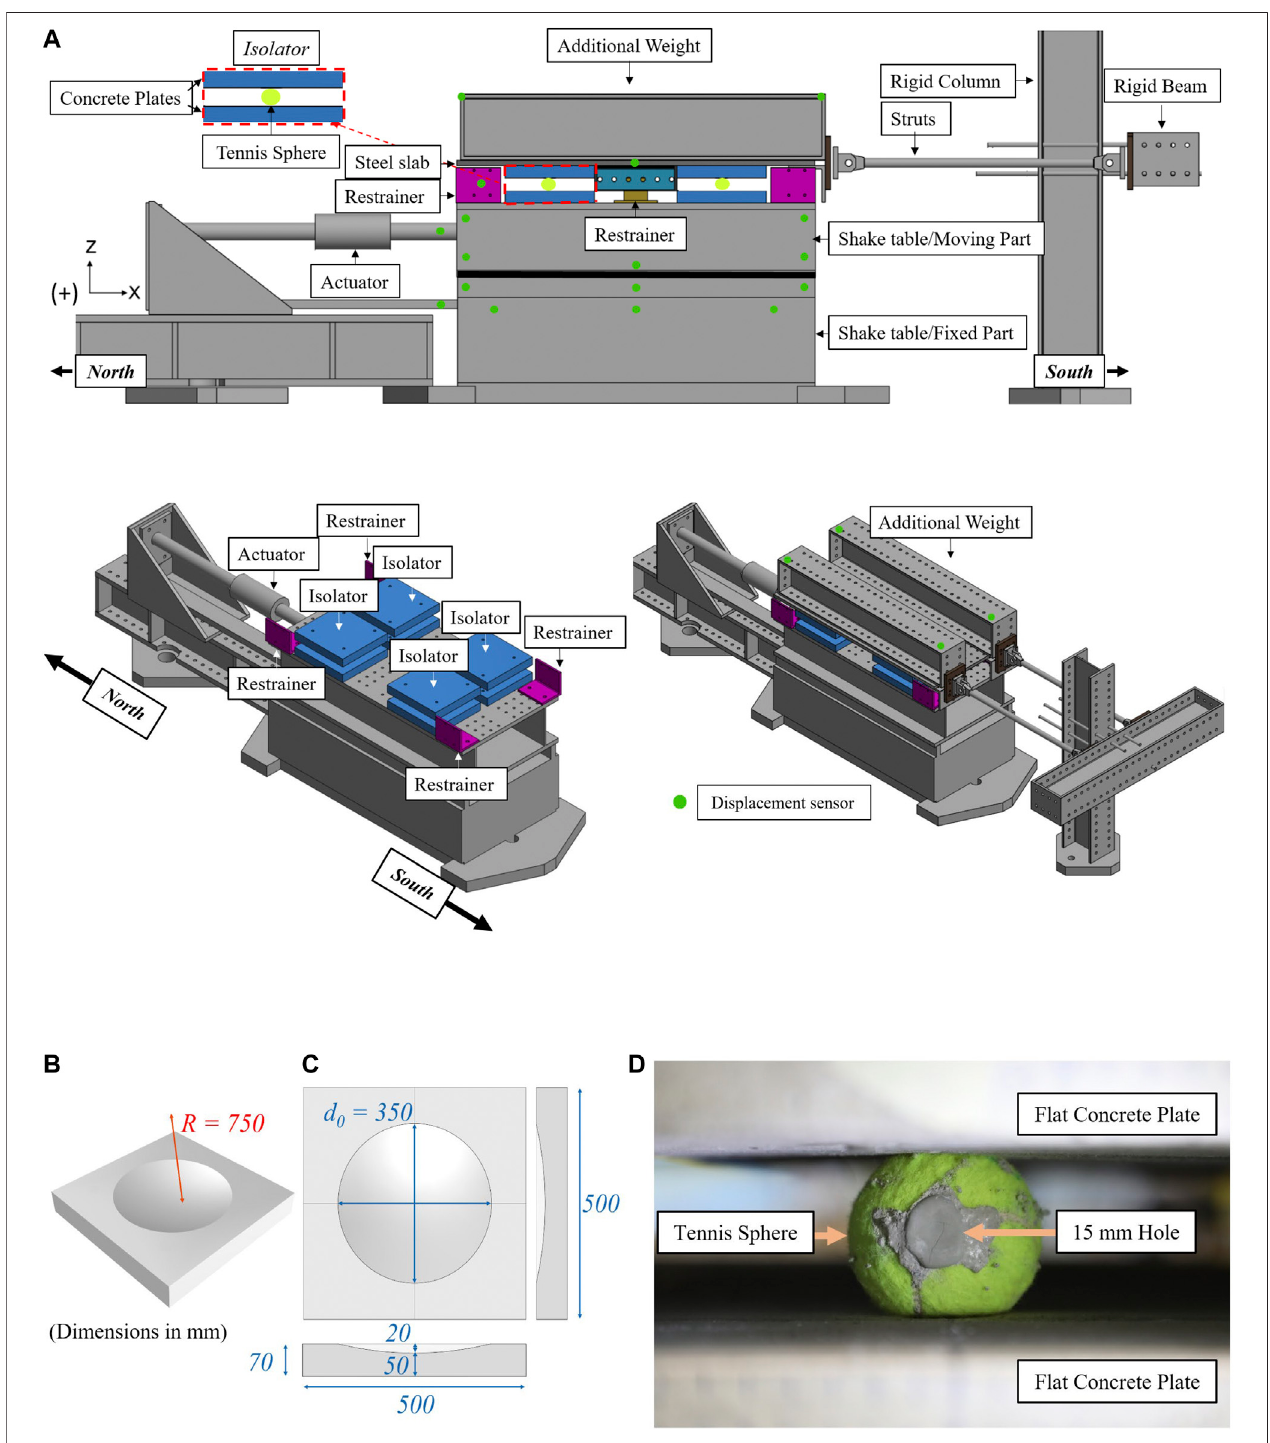
FIGURE4|(A) Schematicrepresentationoftheutilizedexperimentalsetup.Greendotsshowthepositionofthedisplacementsensors. (B) 3Dviewoftheconcave concrete plates; (C) Plan and side view of the concave concrete plates; (D) TBI loaded with 3.23 kN of compressive force between fl at concrete plates.